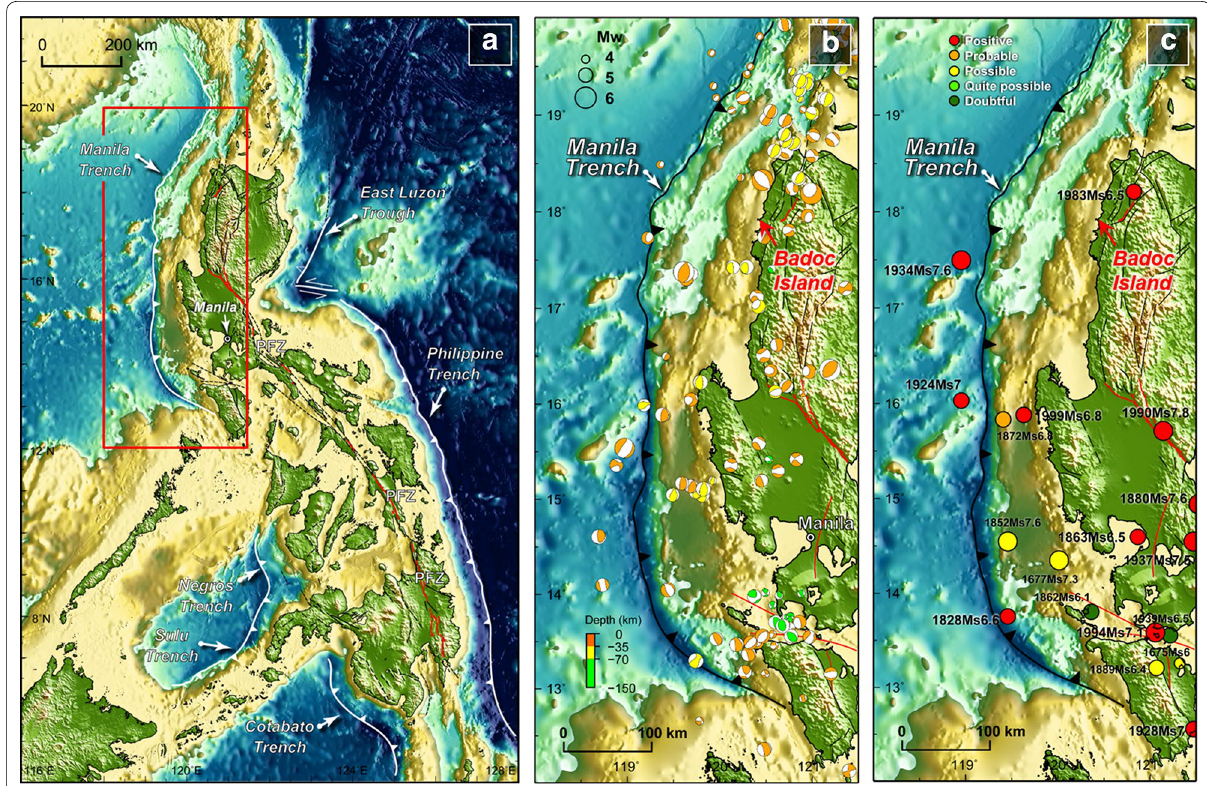
Fig. 1 a Tectonic setting of the Philippine archipelago showing surrounding subduction zones. b Focal mechanism solutions (FMS) (1976–2017) show generally shallow fault activities related to structures along the Manila Trench and onland segments of the Philippine Fault (Tsutsumi and Perez 2013; Philippine Institute of Volcanology and Seismology (PHIVOLCS) 2015). Reported active faults are shown in red. FMS data are from the Global Centroid Moment Tensor (GCMT) catalog. c Tsunami events in west Luzon Island have often been associated with Ms6 to Ms7 earthquakes along the Manila Trench. Tsunamigenic earthquakes that affected west Luzon are shown in Table 4 with their probability ranking and maximum wave height (Bautista et al.